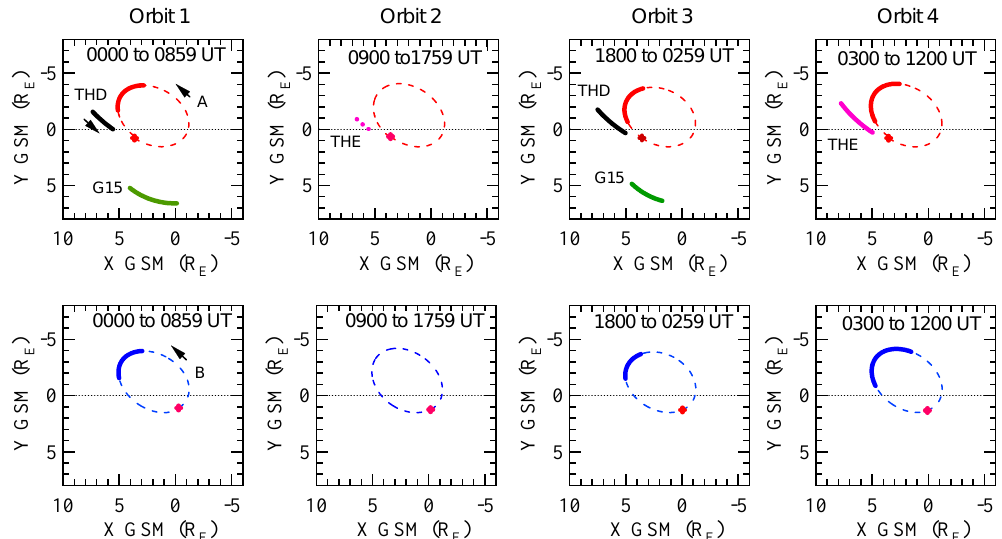
Figure 4. Four successive Van Allen Probe A and B orbits (plotted in red and blue, respectively) in the GSM X – Z plane from 00:00UT on 1 May 2014 to 12:00UT on 2 May 2014. The red dots show the start of the corresponding orbits. The thick red and blue line segments show the locations of Van Allen Probes A and B where the Pc4 magnetic field pulsations occurred on orbits 1, 3 and 4. The green, purple and black lines mark the locations where Pc4 magnetic field pulsations were observed by THEMIS D, THEMIS E and GOES 15, respectively, during the four corresponding